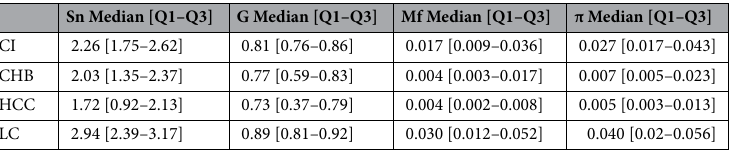
Table 2. Viral quasispecies complexity in the different clinical groups. CHB chronic hepatitis B, LC liver cirrhosis, HCC hepatocellular carcinoma, CI chronic infection, Q1 25th percentile, Q3 75th percentile, HBV hepatitis B virus, ALT alanine aminotransferase. p values ( p ) were obtained by applying the Kruskal–Wallis test in median age, HBV DNA and ALT and by ANOVA in genotype distribution. Statistically relevant p values are reported in bold. p > 0.05 when Tukey multiple comparison was implemented. Genotype was evaluated by NGS sequencing, as described 17 .